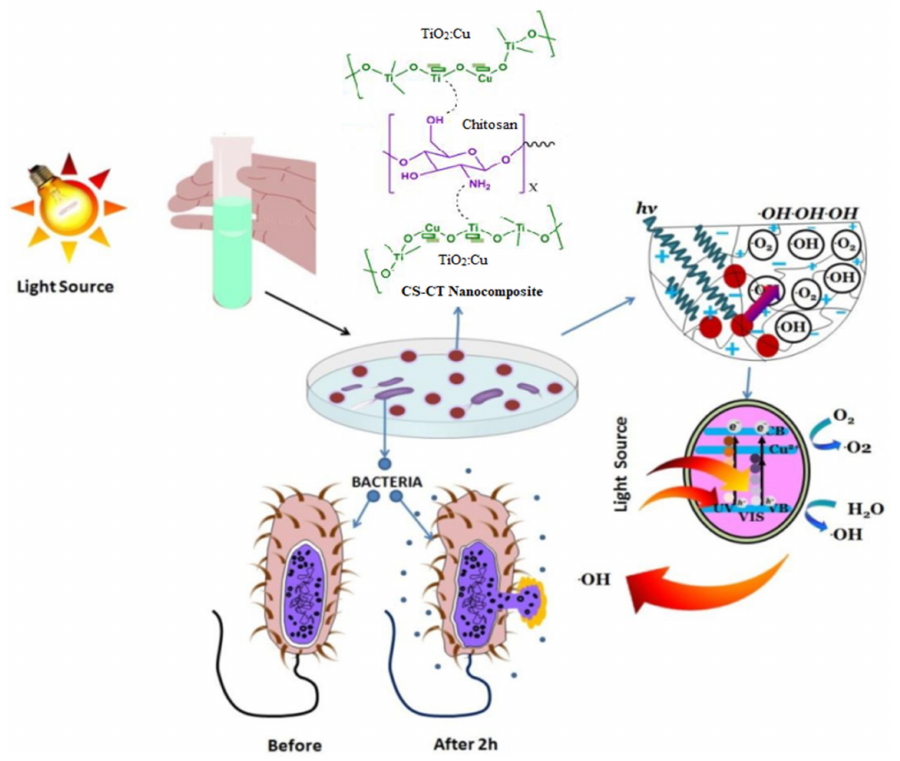
Figure 5. A possible mechanism for photocatalytic antibacterial activity resulting from light stimula- tion of nanocomposites [90]. Reproduced from Raut et